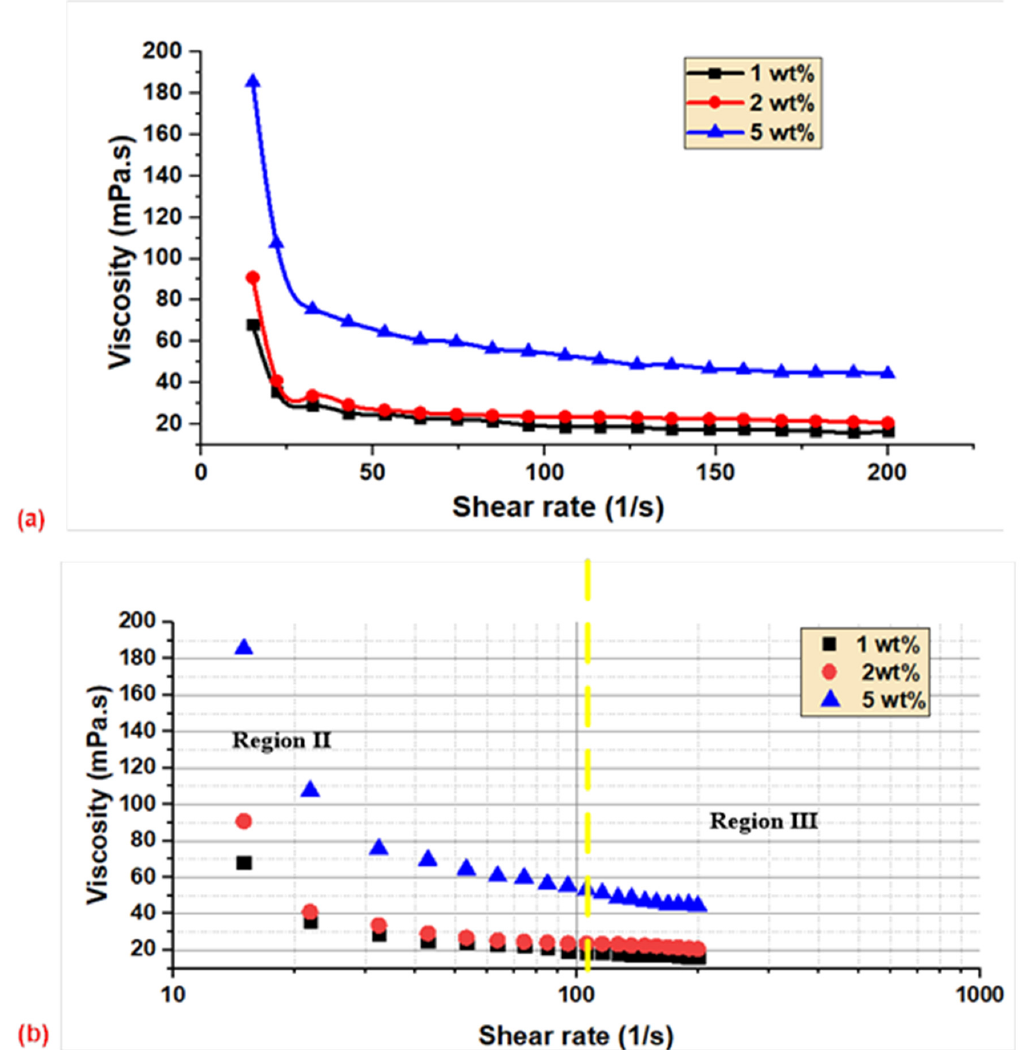
Figure 5. Effect of concentration on the viscosity under shear rates at 25 °C. ( a ) viscosity vs. shear rate for different okra concentrations; ( b ) traditional polymer flow curves report the presence of three regions (Region Ⅰ , Region Ⅱ , Region Ⅲ ). At low shear rates, semi-linear trends or constant plateaus are usually observed to indicate a Newtonian region known as Region Ⅰ , where the shear rates do not alter the polymer viscosity. In the current findings region was not seen. This might be at-tributed to the fact that Region I occurs at low shear rates due to the coherent motion of do- mains.